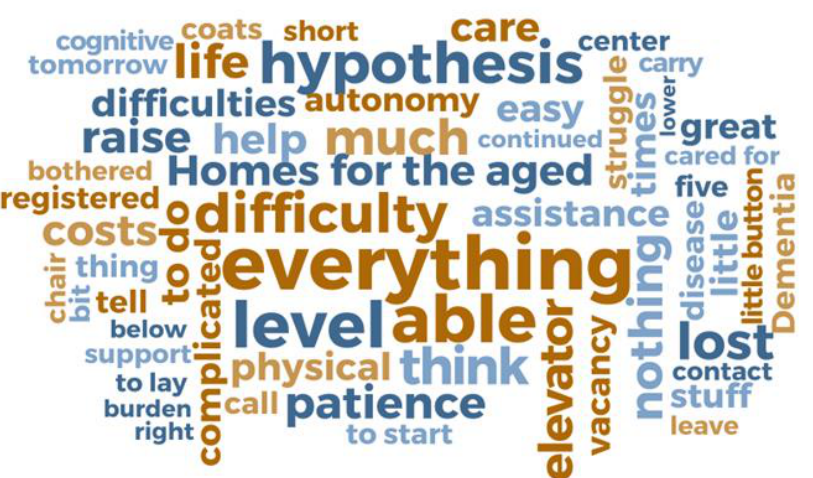
Figure 1. Word cloud. Difficulties in carrying out care by Portuguese caregivers. Via QSR NVivo ® .